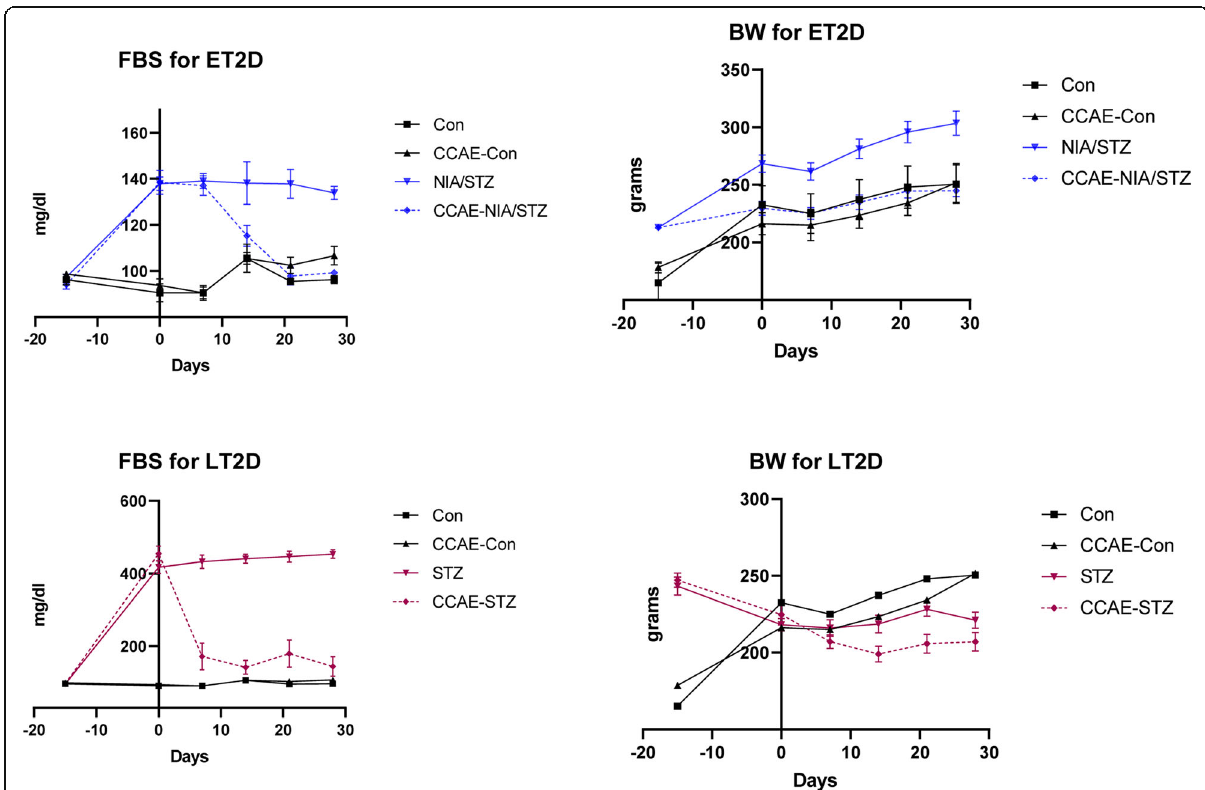
Fig. 2 Weekly FBS and body weights. After diabetes induction (i.e., on day zero), FBS increased ~ 0.44 (44%) and ~ 3.5 (352%) times in NIA/STZ and STZ groups, respectively. By day 28, CCAE had lowered the FBS in both early (CCAE-NIA/STZ group, 133.8 ± 7.9 mg/dl, p = 0.004 vs. NIA/STZ) and late (CCAE-STZ group, 453.0 ± 41.7 mg/dl, p = 0.001 vs. STZ) diabetes groups to a value very close to Con ( p = 0.23 for NIA/STZ group and p = 0.10 for STZ group, vs. Con), a demonstration of the chronic or long-term hypoglycemic effect of CCAE in both early- and late-stage diabetes. On day 28, the body weights of the treated groups were similar to those of corresponding controls (Con vs. CCAE-Con, p = 1.0; NIA/STZ vs. CCAE- NIA/STZ, p = 0.72; STZ vs. NIA/STZ, p = 0.69). Day “ -15 ” indicates the starting day of diabetes induction by STZ or NIA/STZ injection, and day 0 marks the start of daily treatment with CCAE that lasted for 28 days. Con: nondiabetic control, CCAE-Con: nondiabetic control treated with CCAE, NIA/STZ: early-stage diabetic group, CCAE-NIA/STZ: the early-stage diabetic group treated with CCAE, STZ: late-stage diabetic group, CCAE-STZ: the late-stage diabetic group treated with